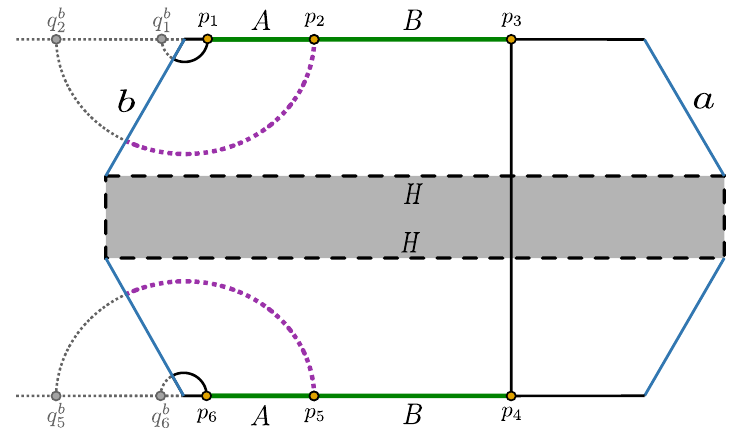
Figure 10 . Here q b = 2 r I − r 1 and q b = 2 r I − r 1 are the mirror images of the points p 2 = r and 2 5 p 5 = r respectively in the two BCFT 2 copies with respect to the b -boundary. The other points are identified similarly as in figure